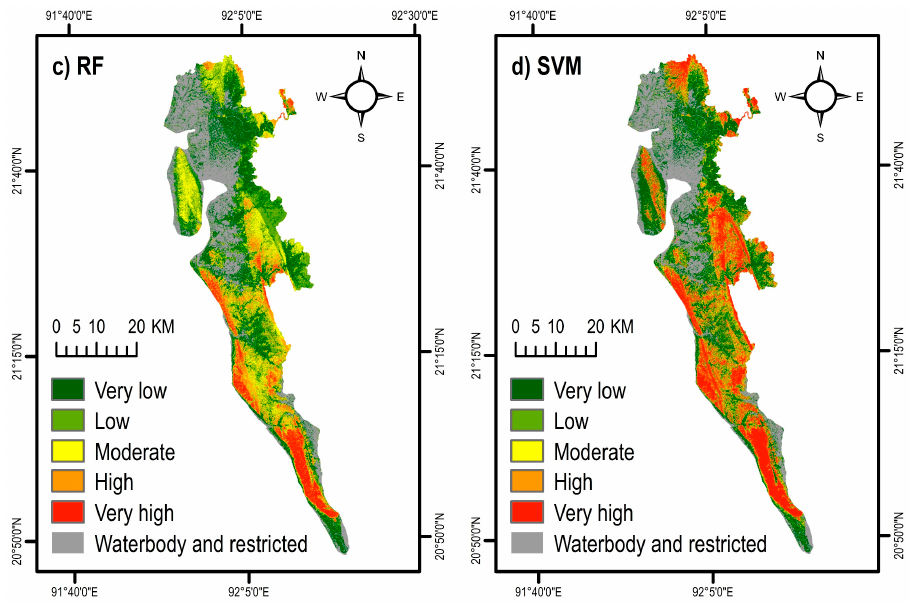
Figure 5. Landslide susceptibility maps obtained by four machine learning algorithms: ( a ) K-Nearest Neighbor (KNN), ( b ) Multi-Layer Perceptron (MLP), ( c ) Random Forest (RF), and ( d ) Support Vector Machine (SVM).